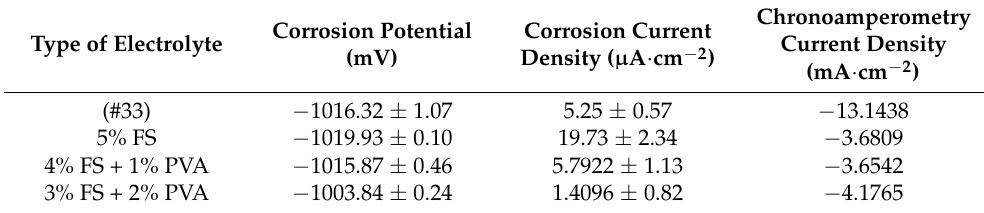
Figure 3. SEM of the zinc working electrode after the chronoamperometry experiment. ( a ) from electrolyte (#33), ( b ) from 5% FS, ( c ) from 4% FS + 1% PVA, and ( d ) from 3% FS + 2% PVA electrolyte. Table 2. Corrosion potential, corrosion current density, and chronoamperometry current density of the zinc working electrode in contact with different